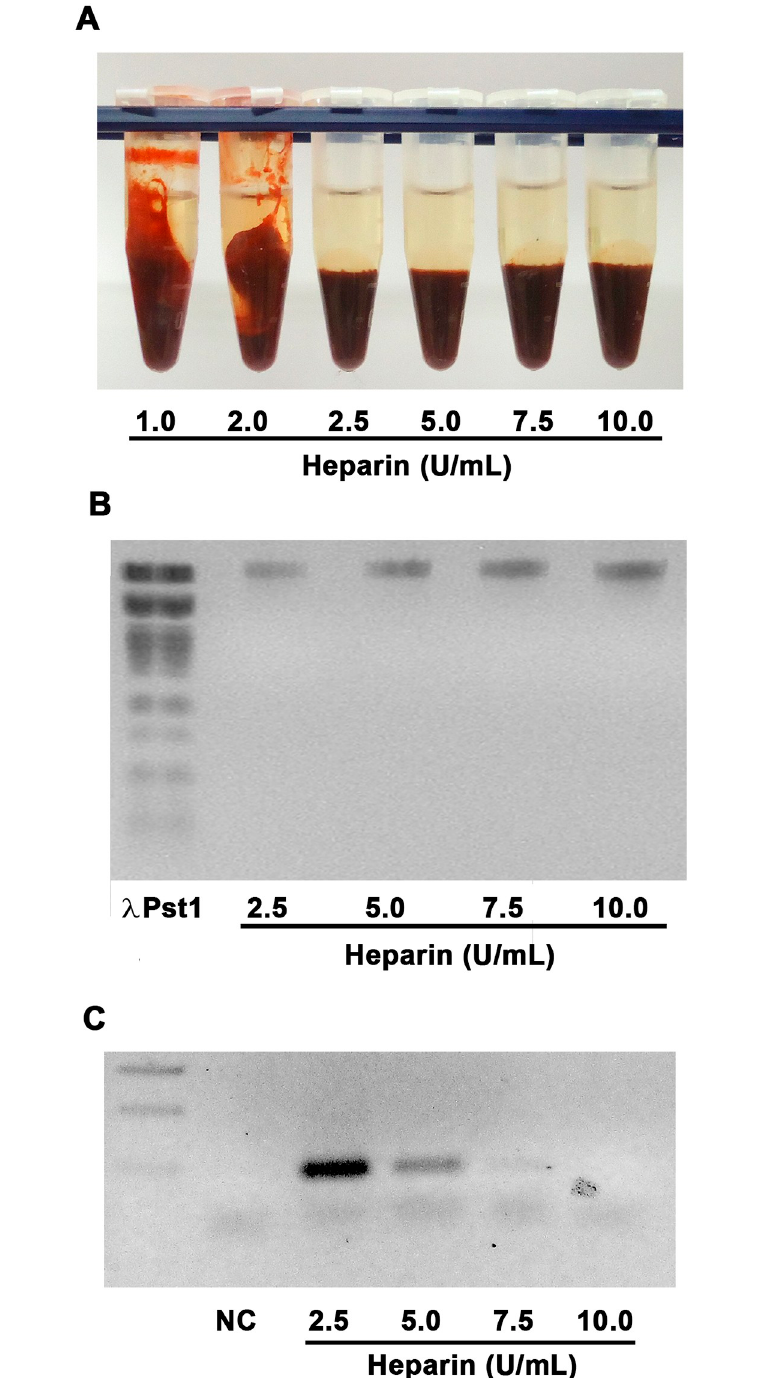
Fig 4. Heparin tests. Rabbit blood was collected with heparin at different concentrations, incubated for 30 min, and centrifuged (A). DNA was purified from the guts of adult females that were fed on blood collected with heparin at different concentrations (B). Purified DNA was used as the template in a polymerase chain reaction using 18S RNA primers (C). NC, negative control.